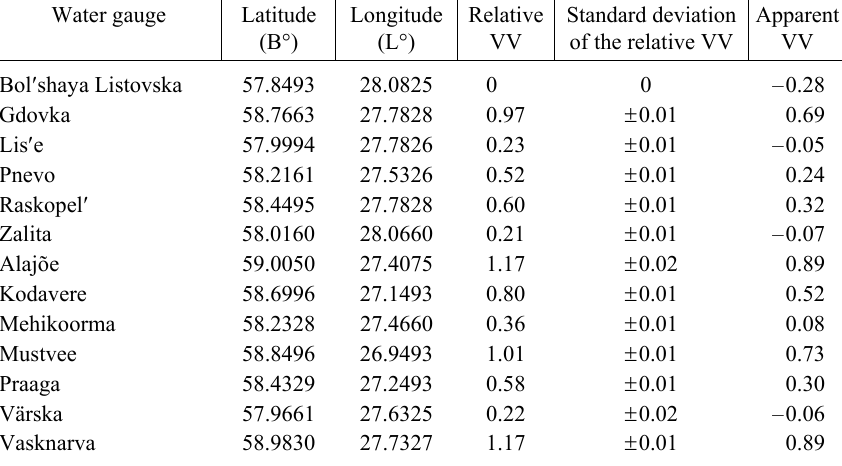
Table 6. Vertical velocities (VVs) and their standard deviations (both mm yr –1 ) at the water gauges (WGs) of Lake Peipsi from the weighted least squares (LSQ) adjustment of the lake tilts according to Raamat (2009). Relative VVs are given with respect to the Bol  shaya Listovska WG whose VV was fixed to zero in the LSQ adjustment. Apparent VVs of the WGs were calculated relative to the Mustvee WG with an apparent VV + 0.73 mm yr –1 . This is the average apparent VV of the five benchmarks (BMs) of the CLN near the Mustvee WG. Apparent VVs of the BMs were obtained through the kinematic adjustment of the CLN